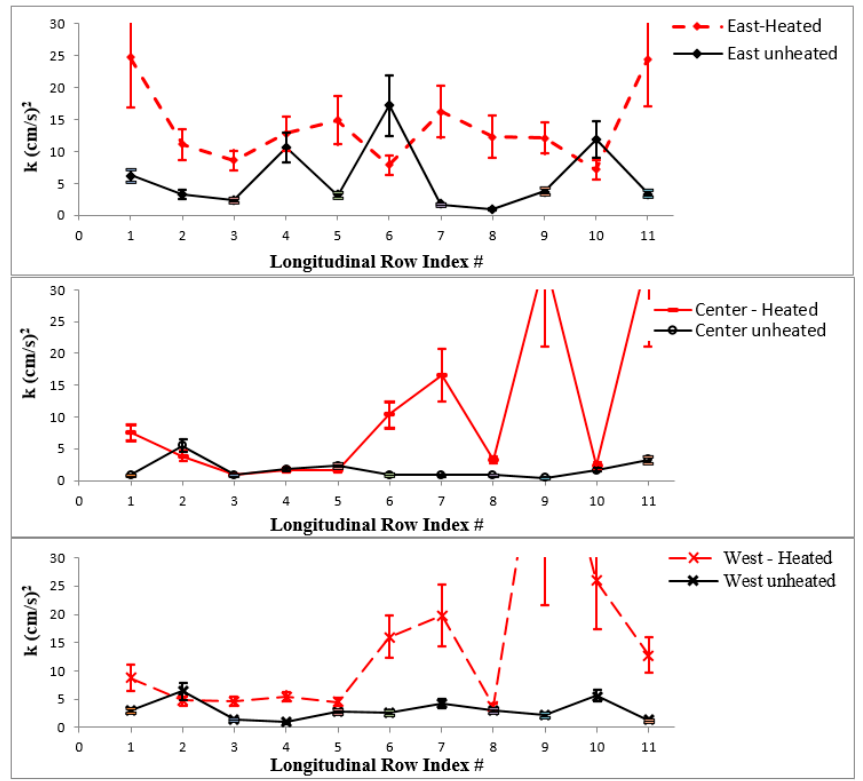
Figure 10. Turbulence kinetic energy comparison for heated and unheated cases in the east, center and west sides of the cabin.